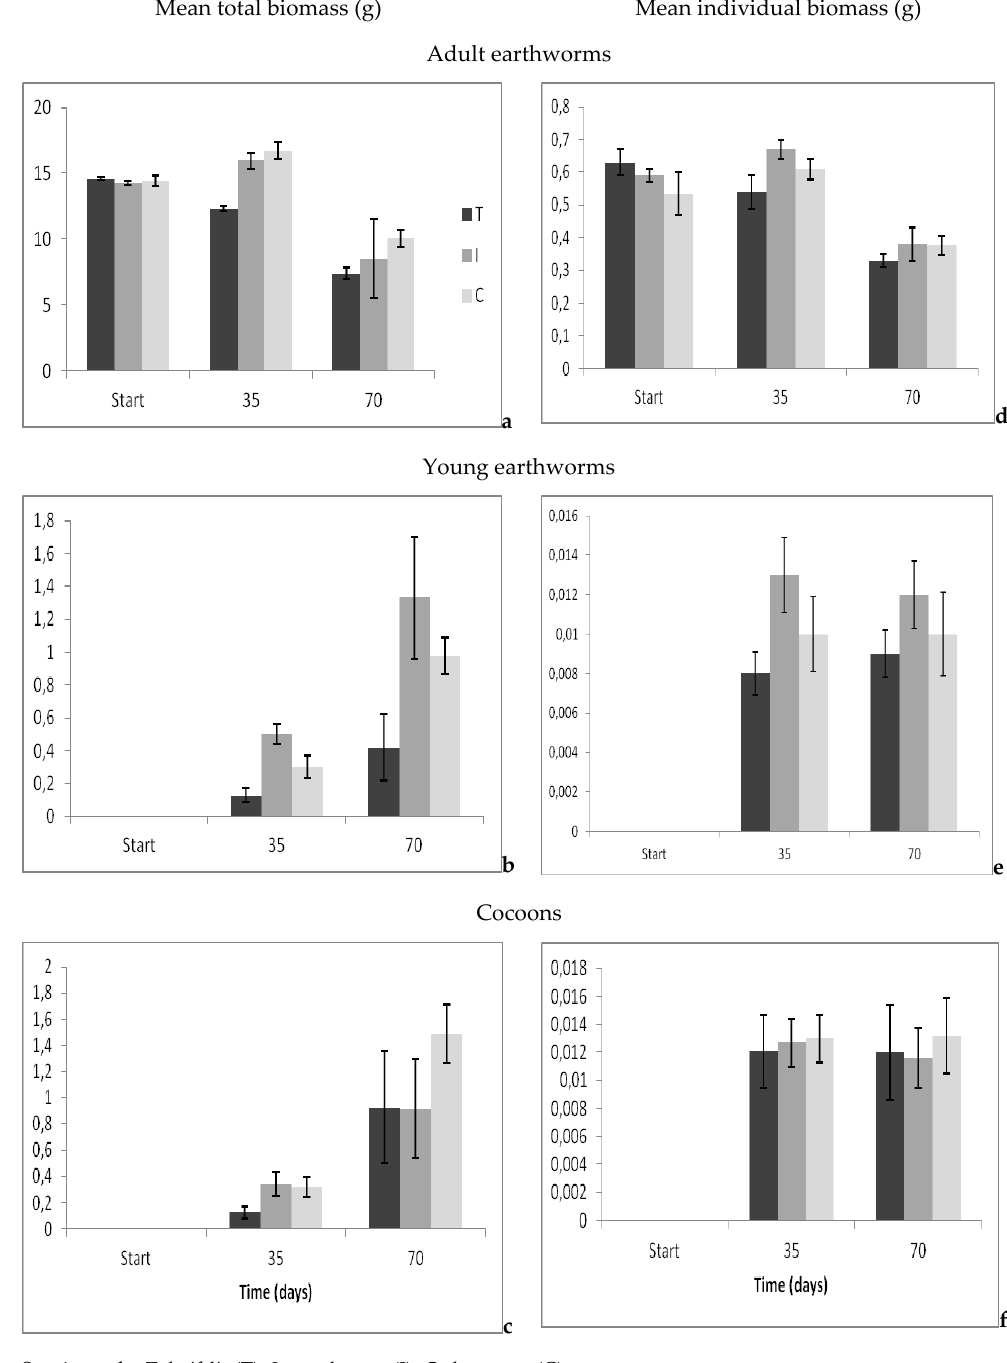
Species code: T. latifolia (T), I. pseudacorus (I), C. demersum (C) Figure 4. Dynamics of the mean sum of biomass and the mean biomass of adult specimens, young specimens and cocoons of E. fetida in the process of vermicomposting of littoral plant biomass.